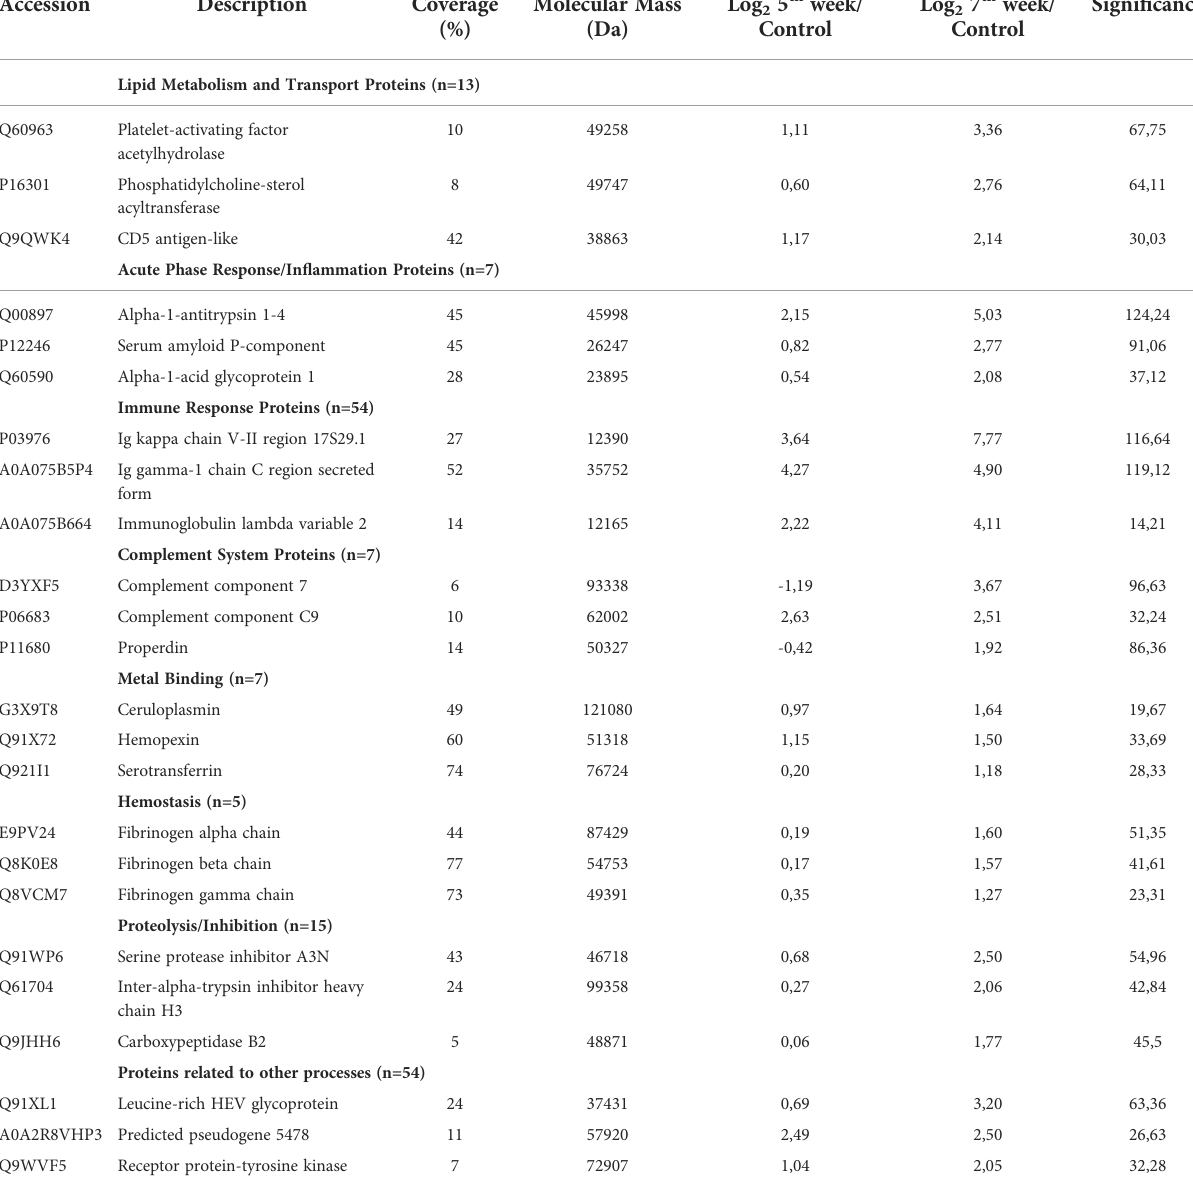
TABLE 1 Consolidated list of the top three differentially abundant proteins categorised according to biological